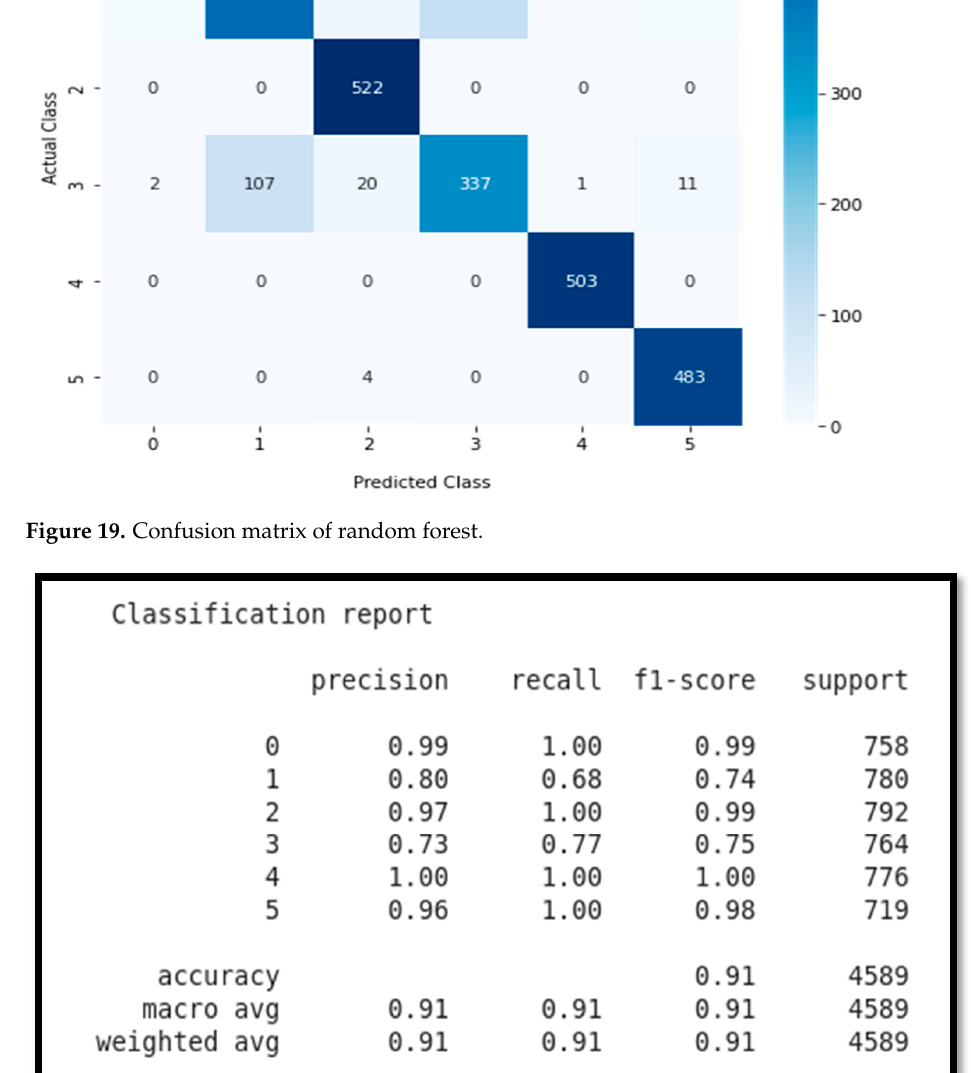
Table 6. Results of logistic regression.